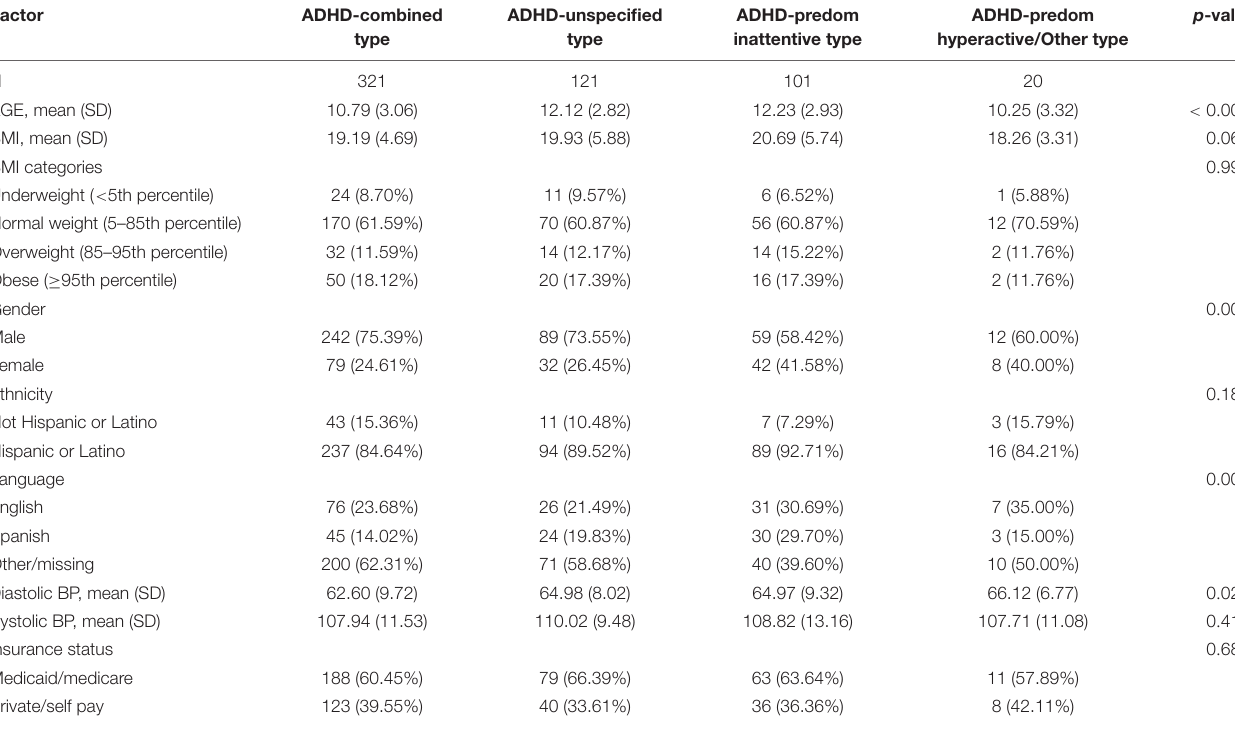
TABLE 4 | Association between specific ADHD status (subset) and variables of interest.